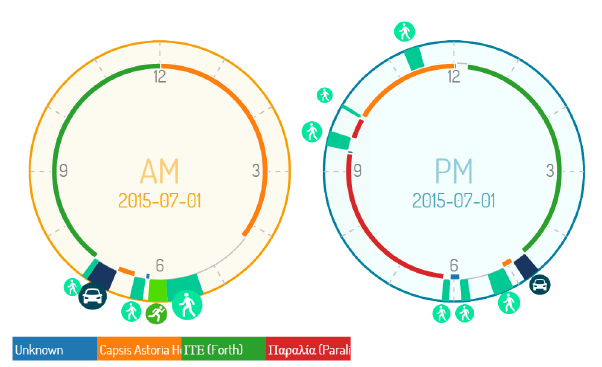
Figure 5 ClockView example